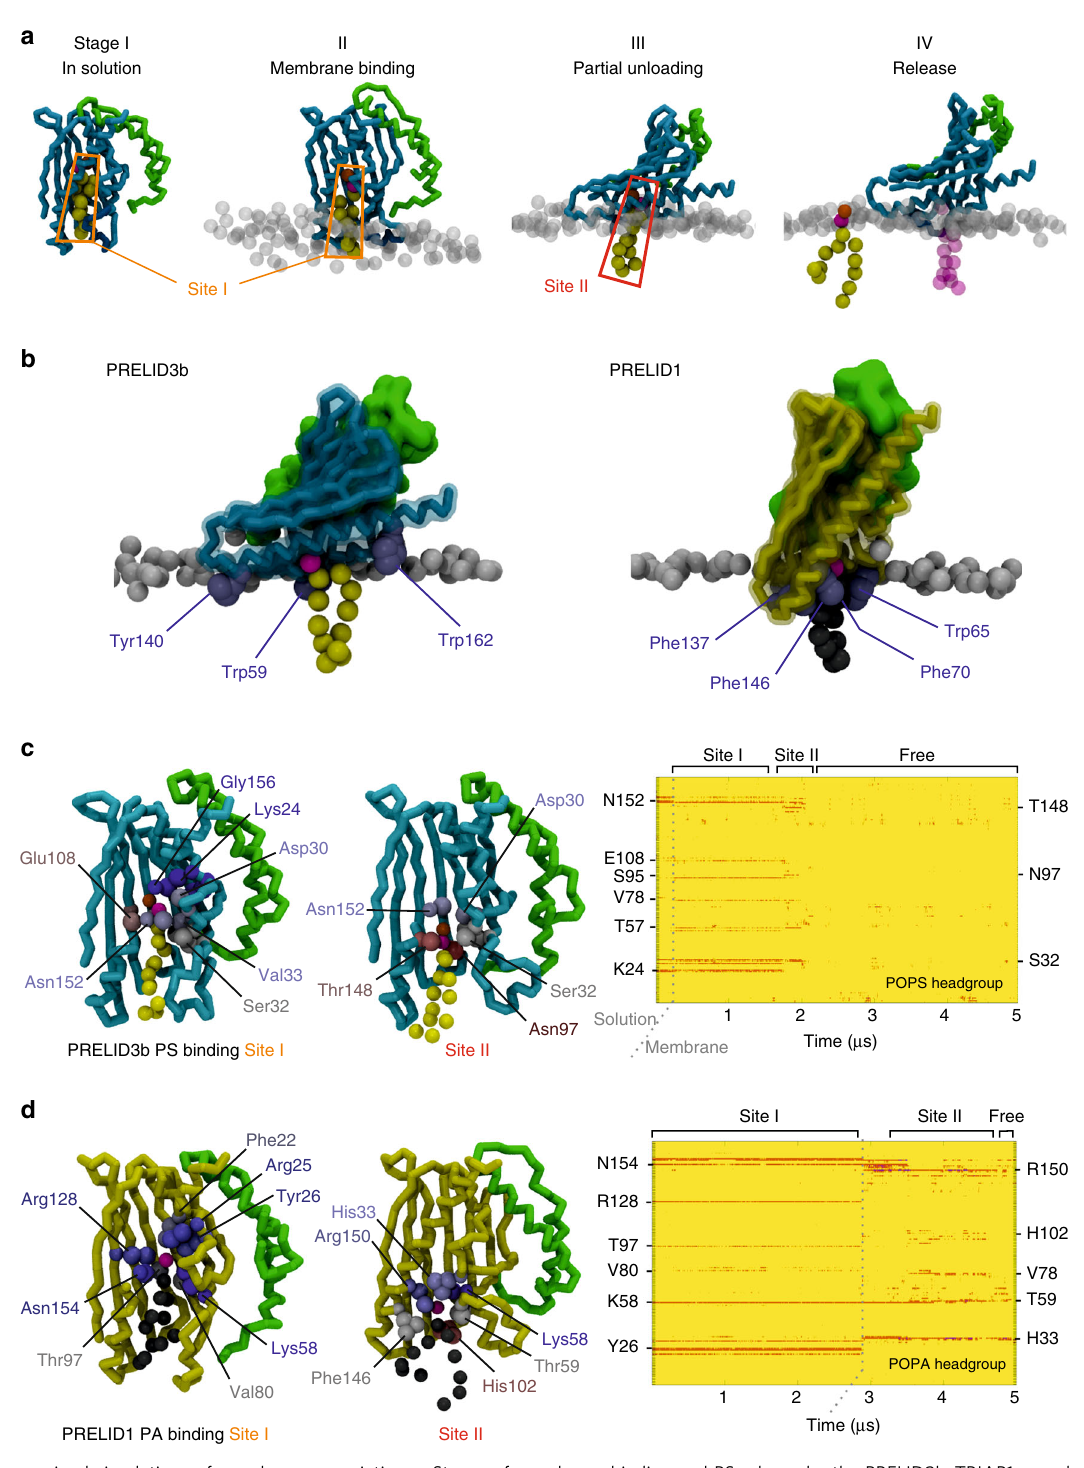
Fig. 7 Coarse-grained simulations of membrane association. a Stages of membrane binding and PS release by the PRELID3b – TRIAP1 complex. Bound PS molecule coloured yellow except for phosphate (magenta) and serine (orange) particles. Final step shows a new PE lipid (magenta, transparent) bound in Site II. PRELID3b (cyan) and TRIAP (green) are shown as a backbone trace, with the Ω loop shown in dark blue. Membrane lipid phosphate groups are shown as grey spheres. b Orientation of PRELID3b (cyan) and PRELID1 (yellow) on the membrane whist lipid is in Site II. Anchoring aromatic residues are shown as purple spheres. c Key residues of PRELID3b in contact with PS phosphate group are labelled for each binding site. Heatmap on the right shows contacts over time for the fi rst simulation. Residues are coloured according to proportion of time in contact with lipid phosphate group over simulation (red minimum, blue maximum). d As c but for PRELID1 and PA. PA is coloured grey with magenta phosphate